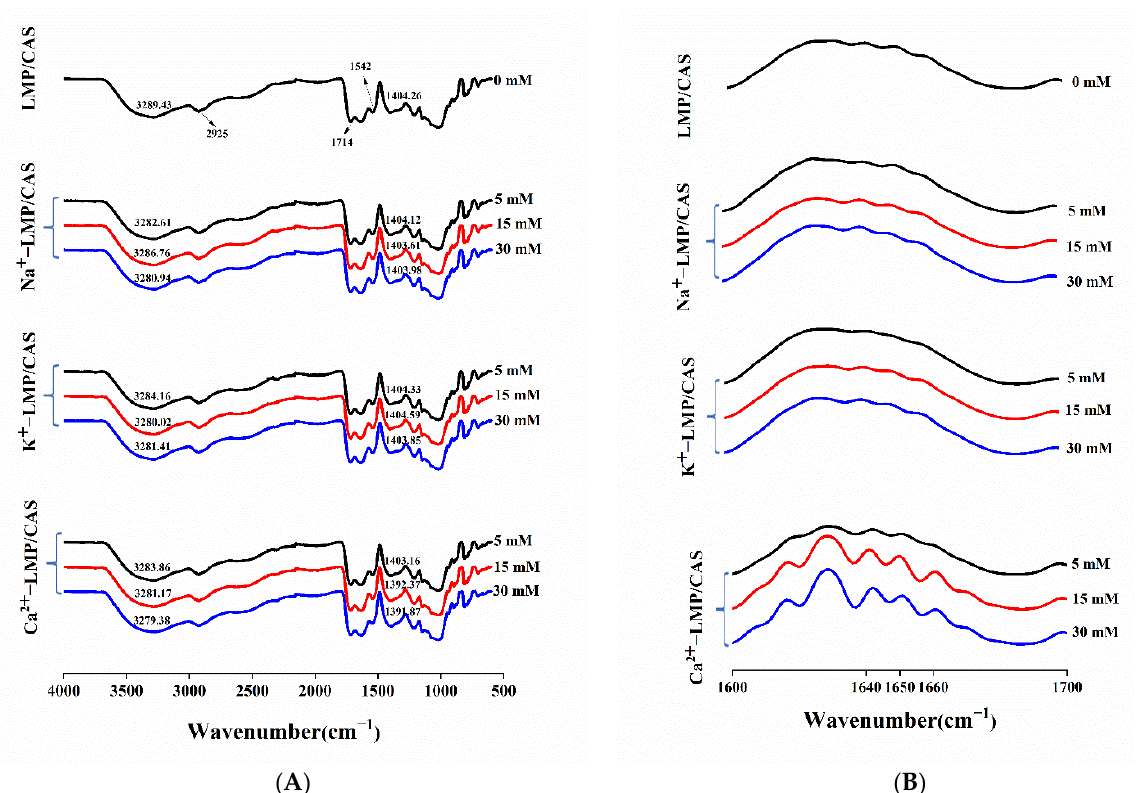
Figure 6. FT-IR spectra ( A ) and spectra of amide I band region ( B ) of the low methoxyl pectin/sodium caseinate (LMP/CAS) complex.